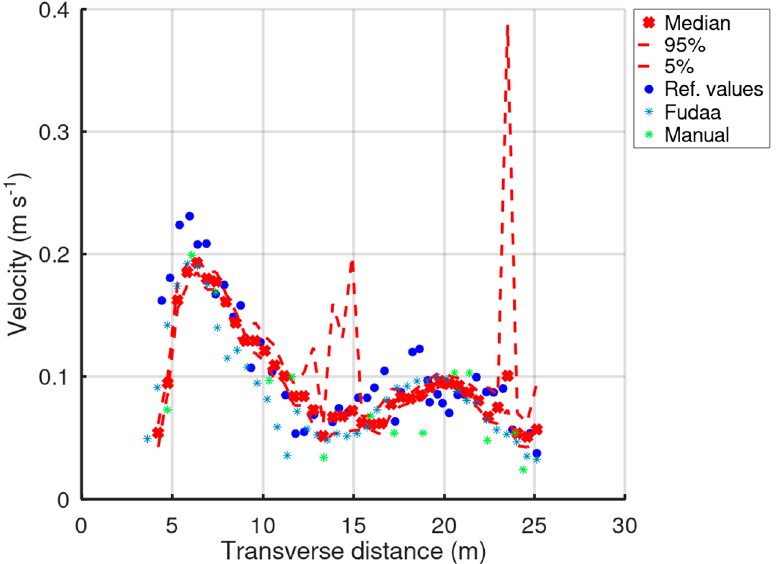
Figure 8. Kolubara River. The Free-LSPIV 90% confidence interval and median values, the reference values, the surface velocities obtained with Fudaa-LSPIV, and the surface velocities estimated manually.